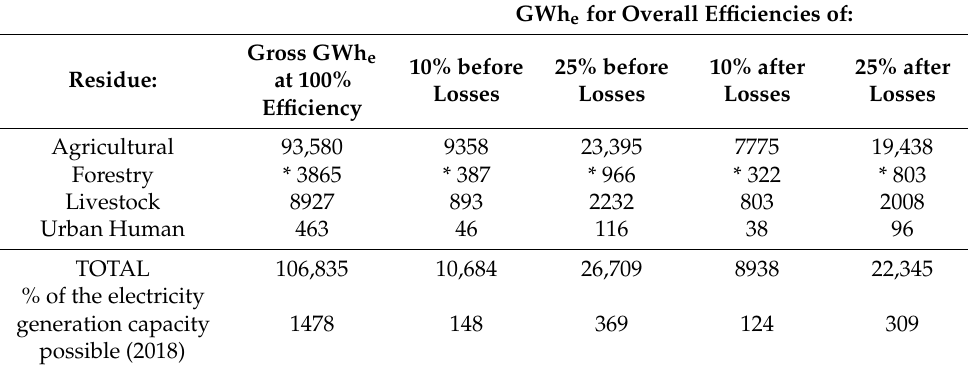
Figure 4. A comparison of the raw energy potential (PJ) of each waste stream. Table 13. A summary of the biomass assessment results for Tanzania. GWh e for Overall Efficiencies